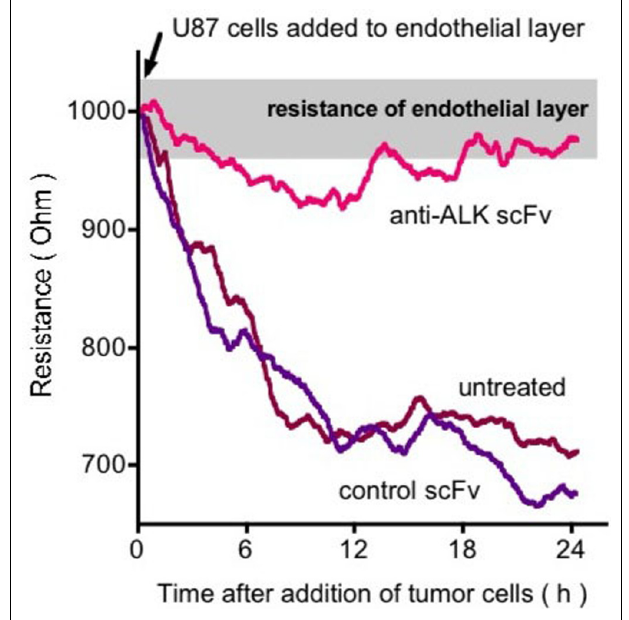
FIGURE 5 | Effect of anti-ALK antibody on U87 GBM cell invasion of an endothelial cell monolayer. Endothelial cell monolayers were formed on electrodes and the intactness of the monolayer was monitored by electrical impedance sensing. Upon addition of the U87 cells the monolayer is disrupted and this is reflected in real-time as a decrease in electrical resistance of the monolayer. Inclusion of an anti-ALK antibody prevents this disruption (Stylianou etal.,